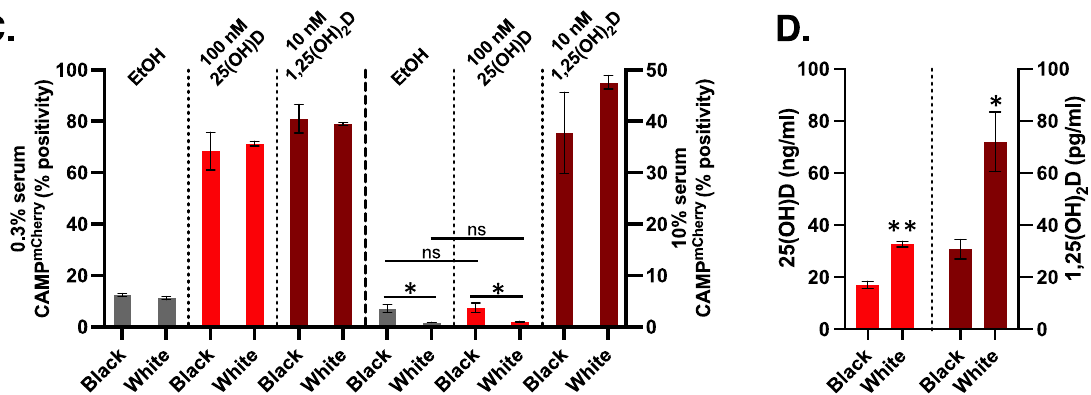
Figure 6. HiTCA response to varying human donor serum concentrations. HiTCA cells were treated with either EtOH (equal volume as vitamin D metabolite solvent), 100 nM 25(OH)D 3 , or 10 nM 1,25(OH) 2 D 3 and one of the following serum treatments: serum-free (SF: no exogenous serum added), pooled human serum (pHS), or individual donor serum. Individual donor serum concentration and culture media conditions were varied as follows: ( A ) 0.3% serum in RPMI and ( B ) 10% serum in RPMI. Data represent the percentage of 10,000 live-gated single-cells that express CAMP mCherry with gate of EtOH-treated WT cells set to 1% positive. Each column represents n = 3 biological replicates ± SEM. Columns representing the three vitamin D metabolite treatments are superimposed according to serum treatment. Vitamin D metabolite treatments are color-coded according to the figure legend. Statistical significance p < 0.001 was attained between individual donors in all treatment conditions by ANOVA. ( C ) Data from panels A and B are displayed as comparisons of average percentage CAMP mCherry signals from the Black (n = 5) and White (n = 5) samples in the various indicated test conditions (y-axis, 0.3% serum on left and 10% serum on right) and above the column graphs (EtOH, 100 nM 25(OH)D 3 , or 10 nM 1,25(OH) 2 D 3 ). Differences between Black and White samples were observed in only two conditions, * p < 0.05. Differences between EtOH and 100 nM 25(OH)D 3 , and EtOH and 10 nM 1,25(OH) 2 D 3 within corresponding Black/White groups were all significant ( p < 0.01) with the exception of two indicated non-significant (ns) comparisons. ( D ) Measured serum 25(OH)D (left axis) and 1,25(OH) 2 D (right axis) mean concentrations of the Black and White samples used in study. * p < 0.05 and ** p < 0.001 was observed comparing Black with White